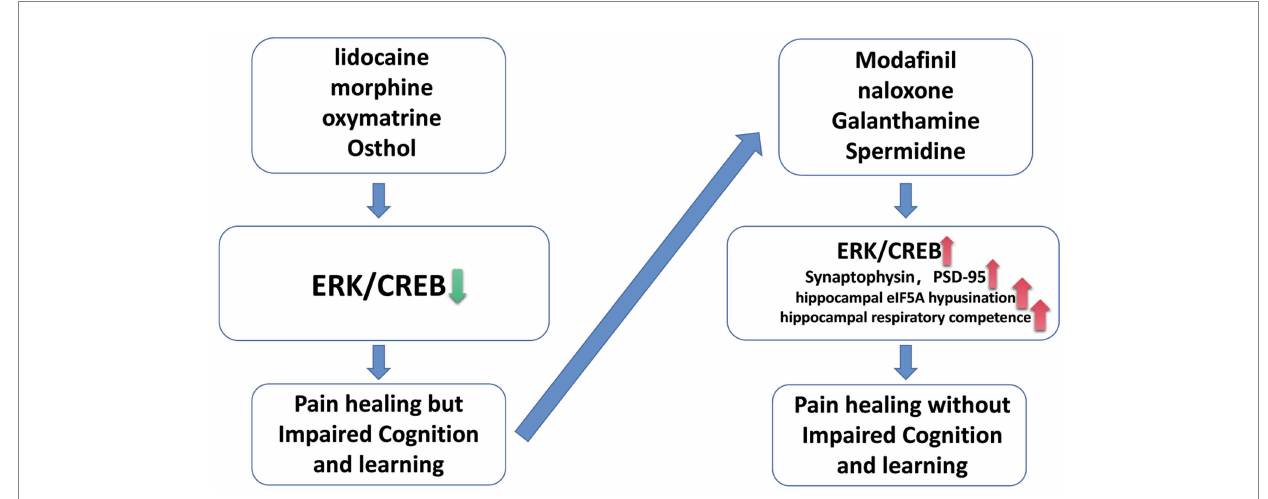
FIGURE 1 Some strategies for treating pain while avoiding cognitive